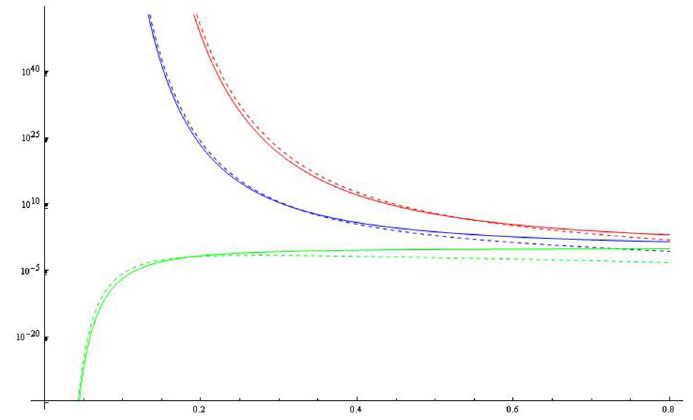
Figure 1 . Comparison between the classical and the quantum partition function: the dashed lines are the exact result (5.3) while the solid lines are the saddle point approximation (6.7). The horizontal axis is b , while different values of A correspond to curves of different colors: A = 0 . 1 (red), A = 1 (blue), A = 10 (green). This manifestly shows that the semiclassical approximation matches the exact result for small b and for all values of A